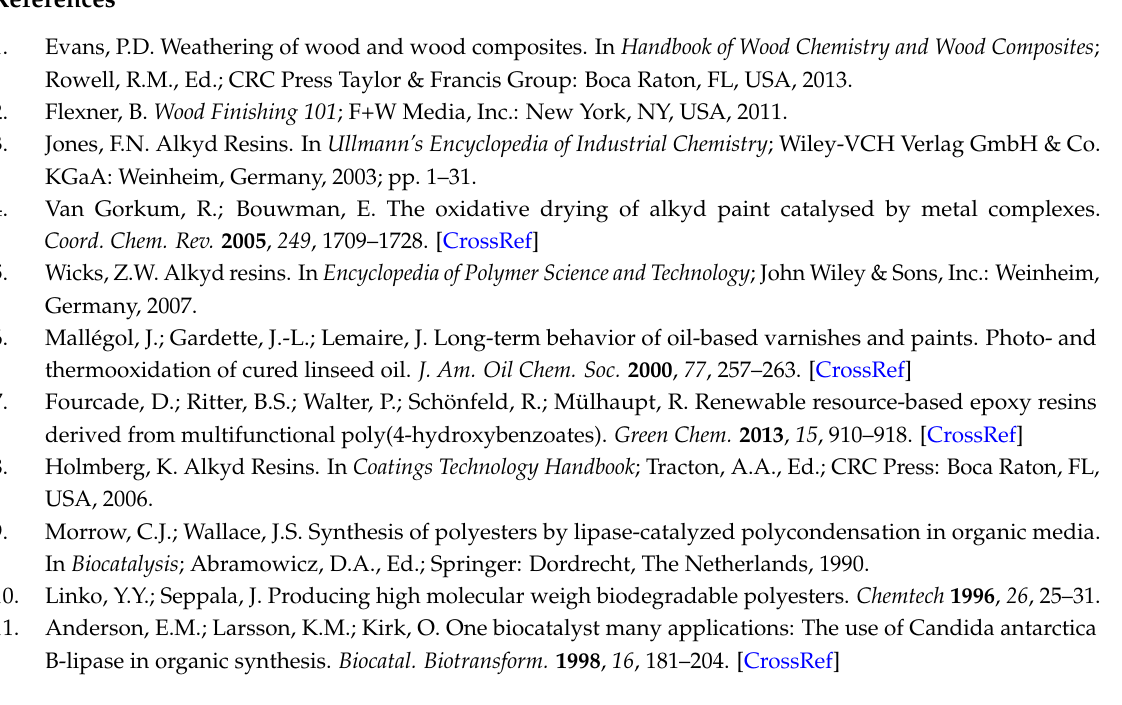
Table S1. Fatty acid (methyl ester) composition of the TOFA sample, Figures S1–S25 with additional